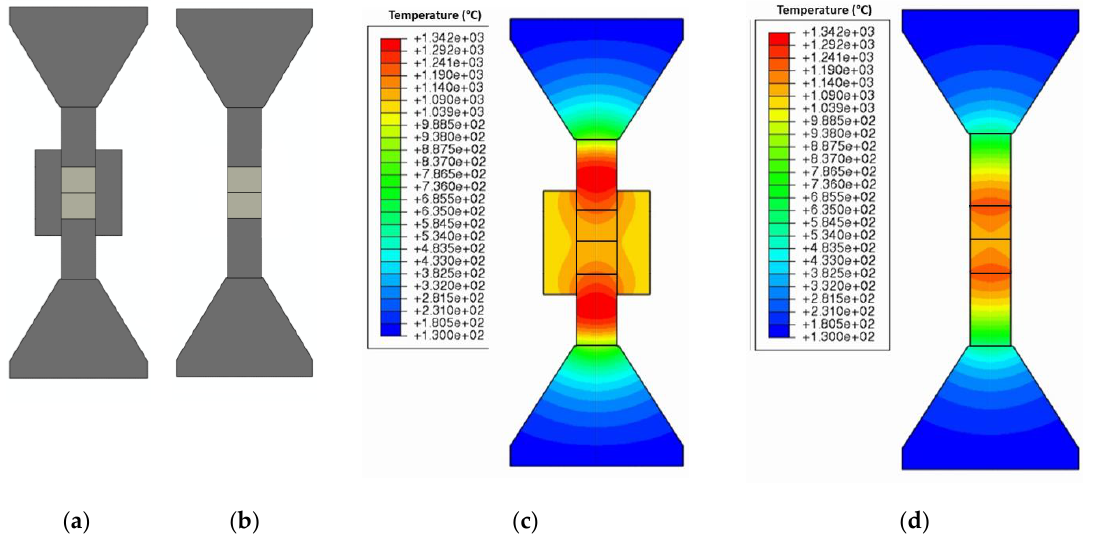
Figure 1. SPS configurations investigated in this study where ( a ) uses a die and ( b ) does not use a die. Numerical thermal mapping for both configurations where ( c ) represents the experimental setup with a die and ( d ) is without a